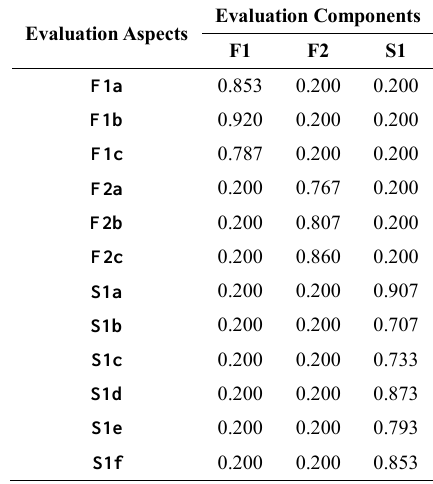
Table 5. Initial Data for the Weighted Product Method Calculation Simulation